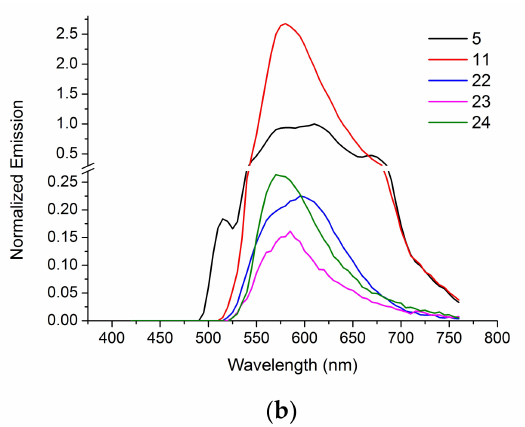
Figure 3. The normalized absorbance ( a ) and emission ( b ) spectra of the dyes ( 5 , 11 ) and the conjugates ( 22 – 24